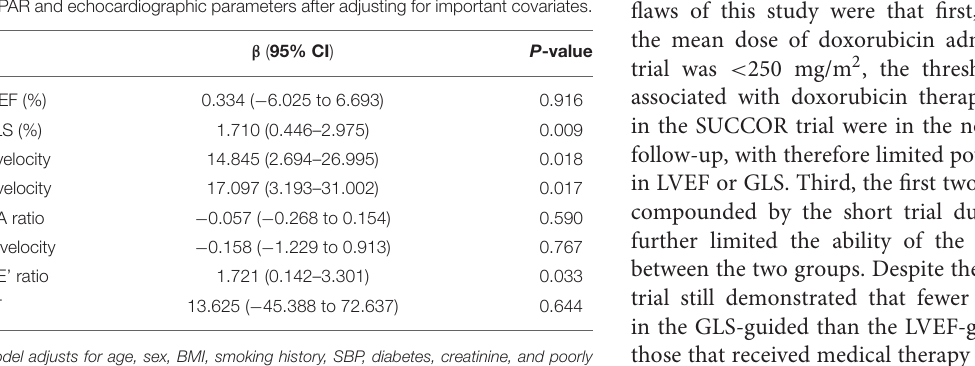
Model adjusts for age, sex, BMI, smoking history, SBP, diabetes, creatinine, and poorly differentiated histology. DT, Deceleration Time; LVEF, Left Ventricular Ejection Fraction; GLS, Global Longitudinal Strain.